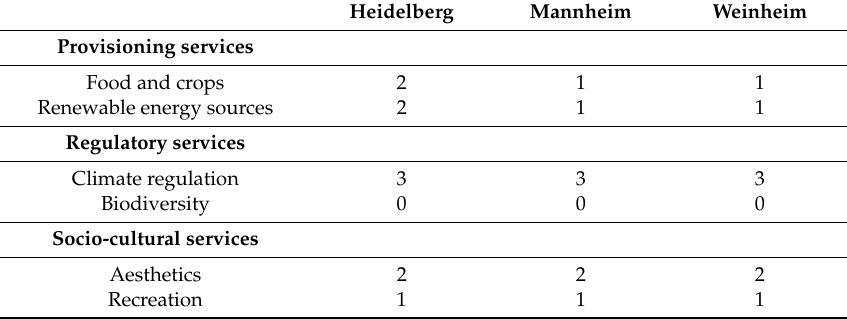
Table 2. Supply matrix for selected ecosystem services for the three study sites. Capacity to provide ecosystem services: 0 = no relevant capacity, 1 = relevant capacity, 2 = high relevant capacity, 3= maximum relevant